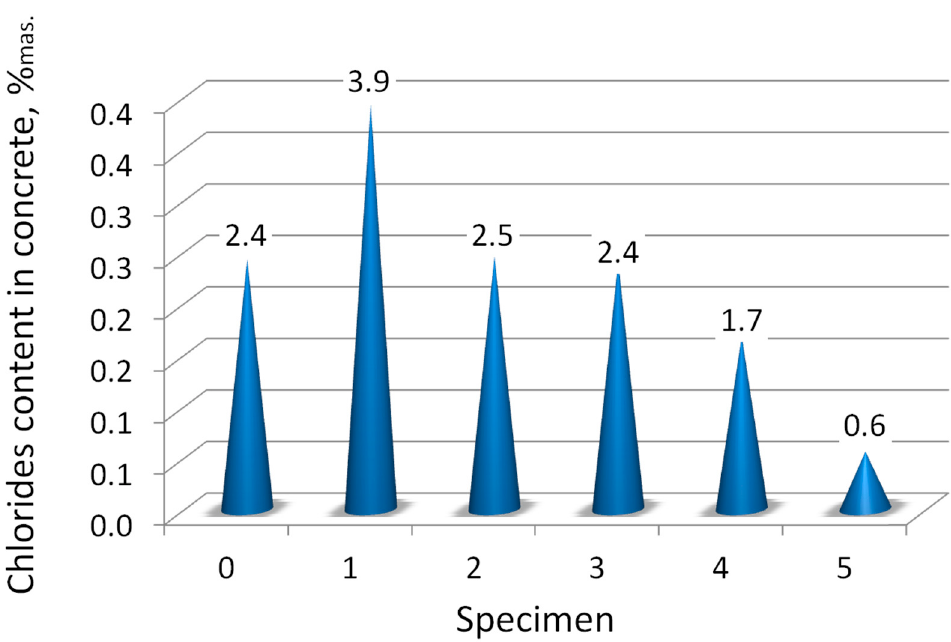
Figure 11. The free chloride ions content in concrete samples from the bridge.